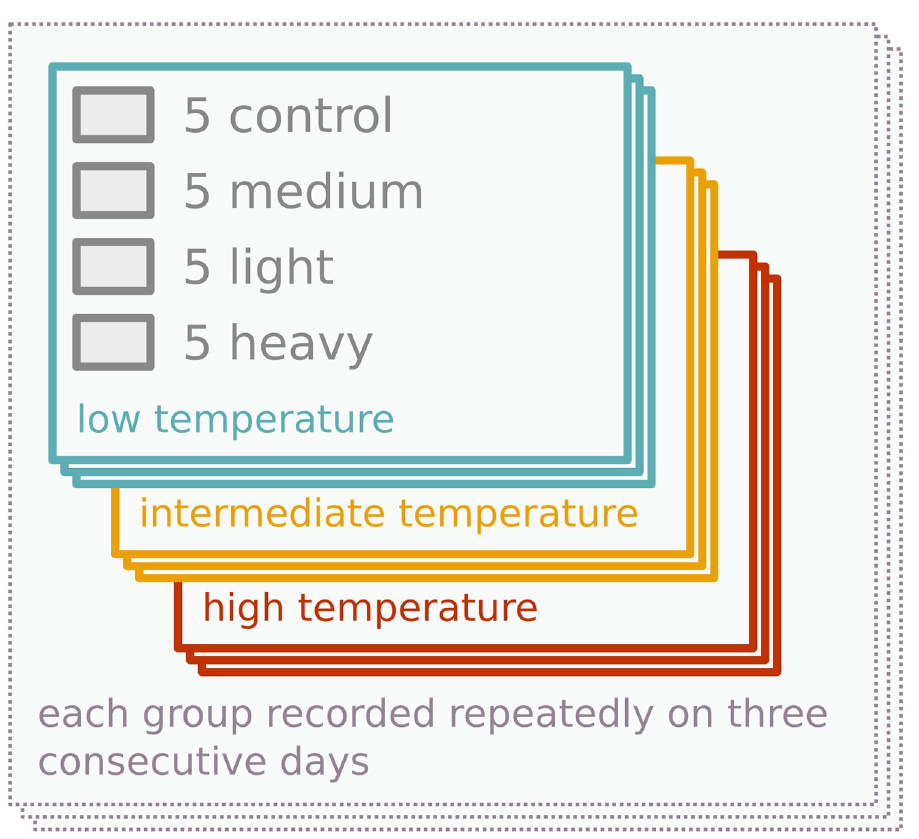
Fig 3. Experimental design. There were 5 control individuals and 5 individuals for each tag weight category in each group. Movement of each group at one of three temperatures (19.5, 24.0, or 28.3˚C) was recorded repeatedly on 3 consecutive